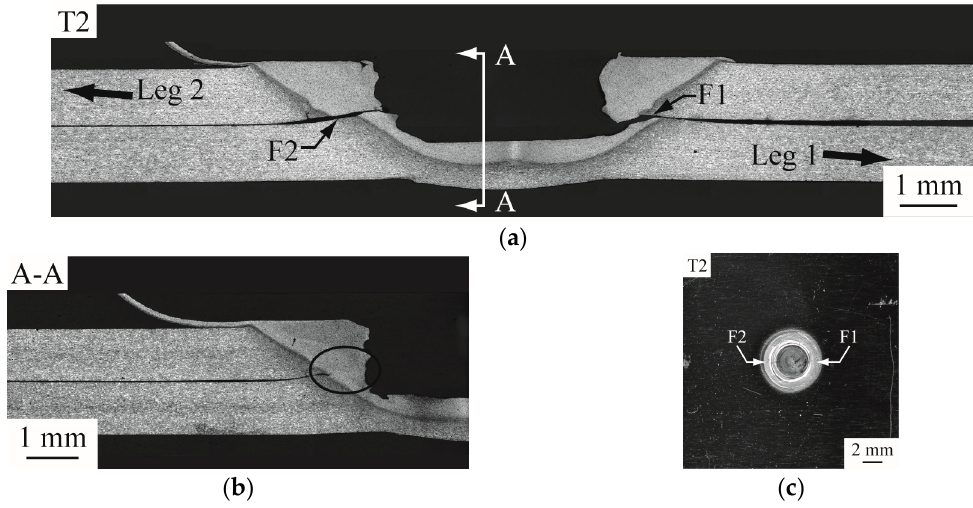
Figure 10. ( a ) an optical micrograph of the cross section of a partially failed FSSW; ( b ) an optical micrograph of the cross section along A-A plane in ( a ); ( c ) a top view of another failed FSSW on the lower sheet.